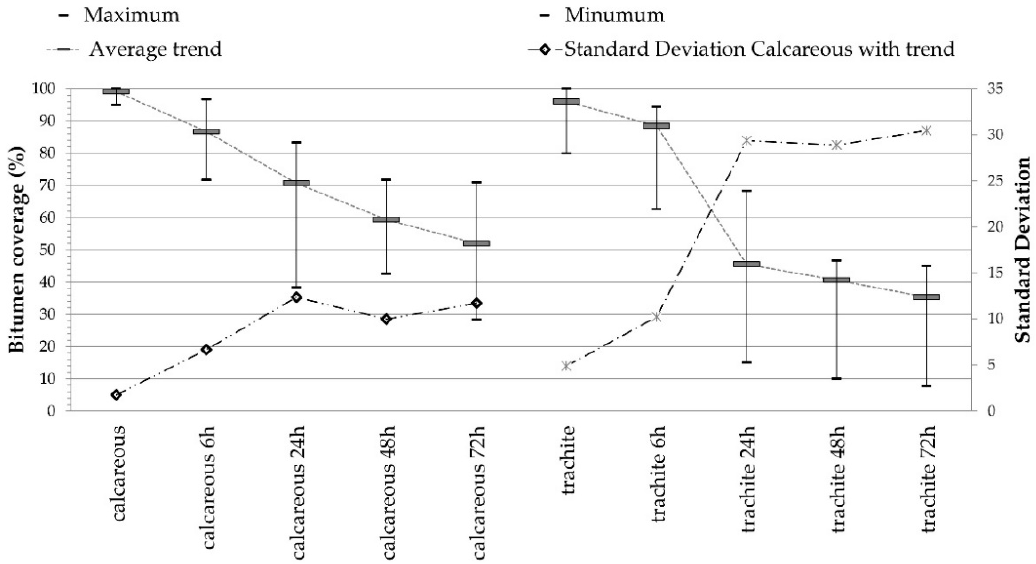
Figure 4. Bitumen coverage trend obtained via visual inspection. The plot shows the minimum, maximum, averaged values, and trend of standard deviation variation during the rolling time.